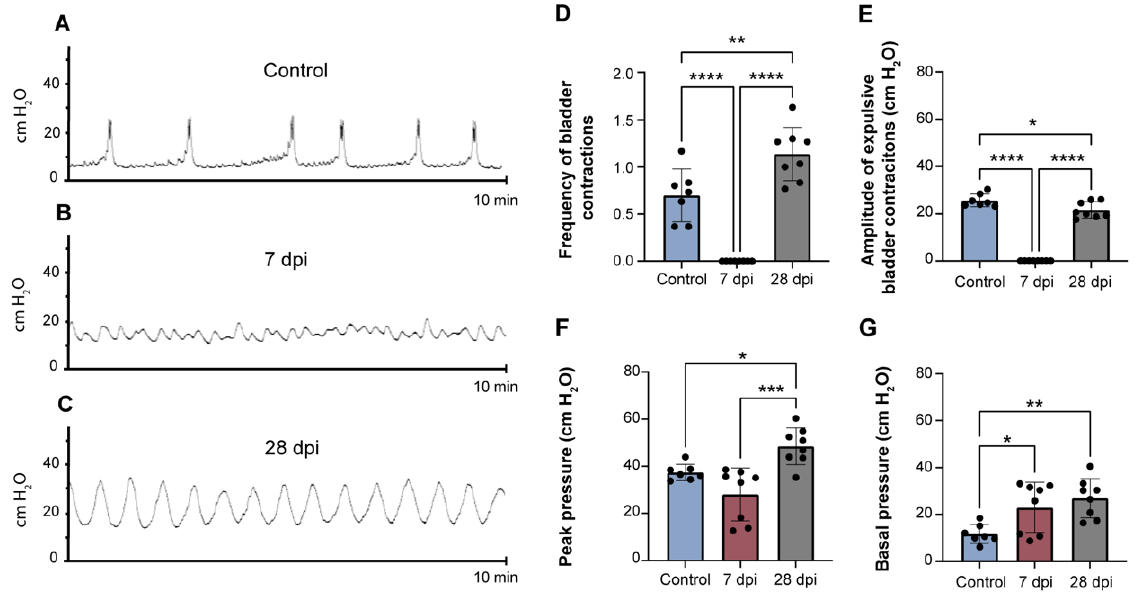
Figure 1. Representative cystometrograms depicting the voiding pattern of animals with intact spines (control) and after spinal cord injury. Control animals exhibited a normal pattern of bladder reflex activity ( A ). SCT animals exhibited hallmarks of bladder dysfunction. At 7 days post-injury (7 dpi), bladder contractions with an amplitude higher than 5 cm H 2 O were nonexistent ( B ), while at 28 days post-injury (28 dpi) a typical pattern of NDO was well established ( C ), evidencing signs of strong, frequent and involuntary bladder contractions. Analysis of urodynamics parameters, such as frequency of bladder contractions ( D ), amplitude of expulsive bladder contractions ( E ) and peak ( F ) and basal pressures ( G ) are also detailed. Graphs represent mean ± SD and p < 0.05 was considered statistically significant. * p ≤ 0.05; ** p ≤ 0.01; *** p ≤ 0.001; **** p ≤ 0.0001; one-way ANOVA followed by Tukey’s multiple comparison